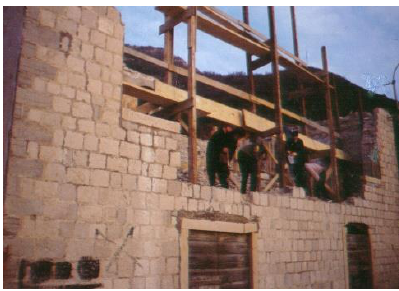
Figure 32. The façade had to be taken down due to the forced protrusion.